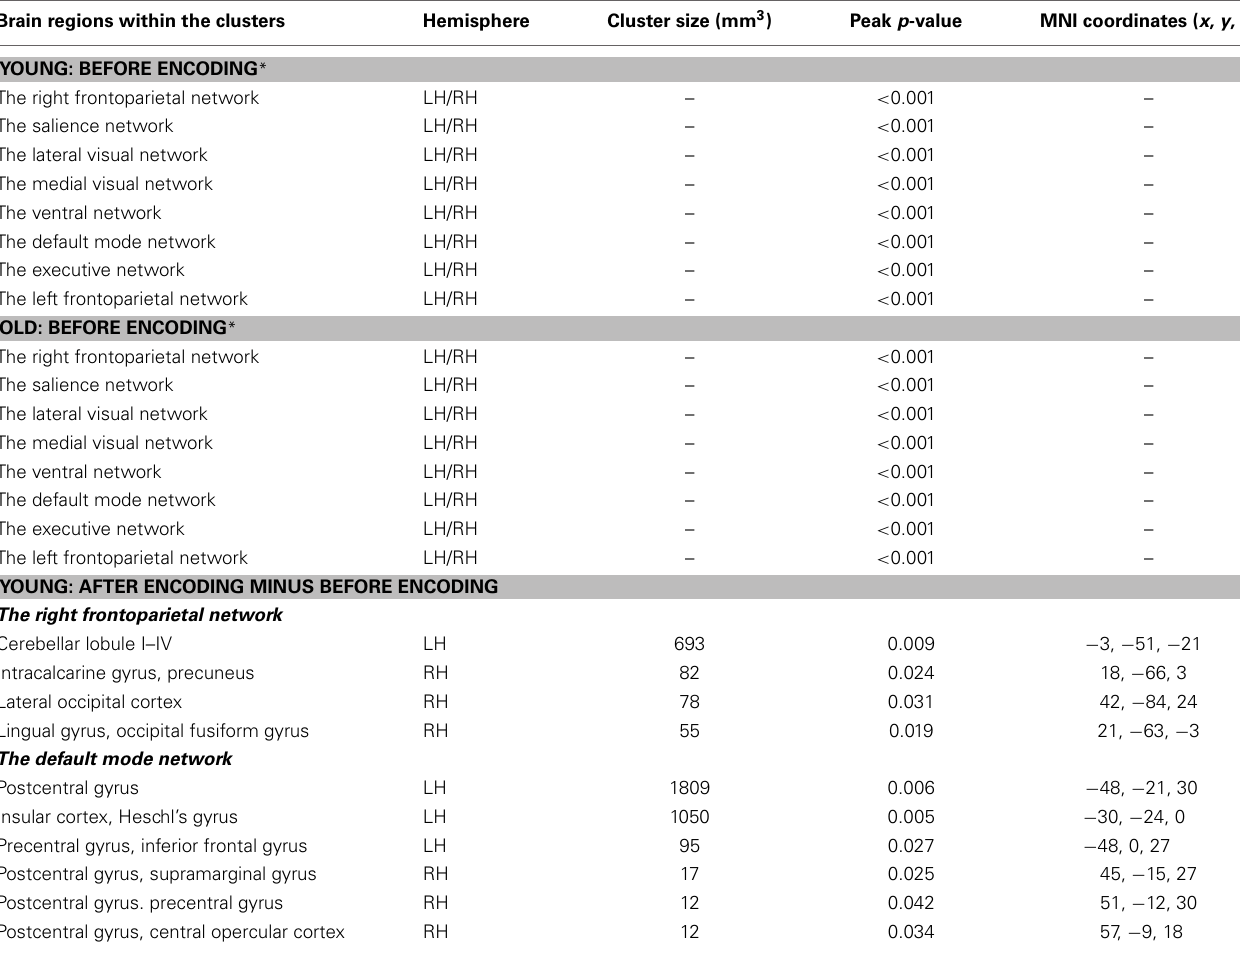
Table 2 | Resting-state connectivity between networks of interests and the whole brain within the young and older